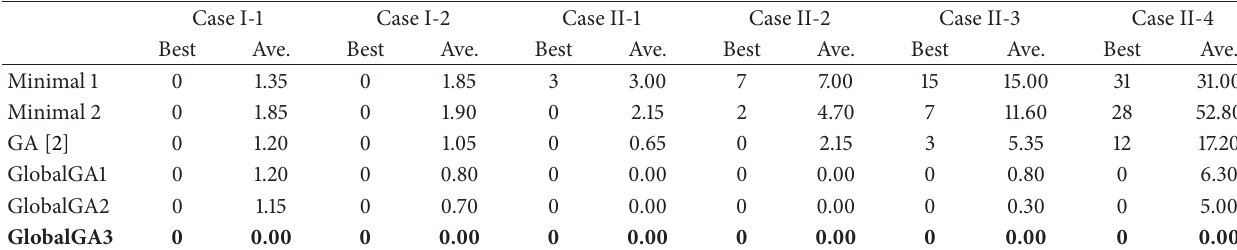
Table 2: Comparative results with existing methods (number of coding